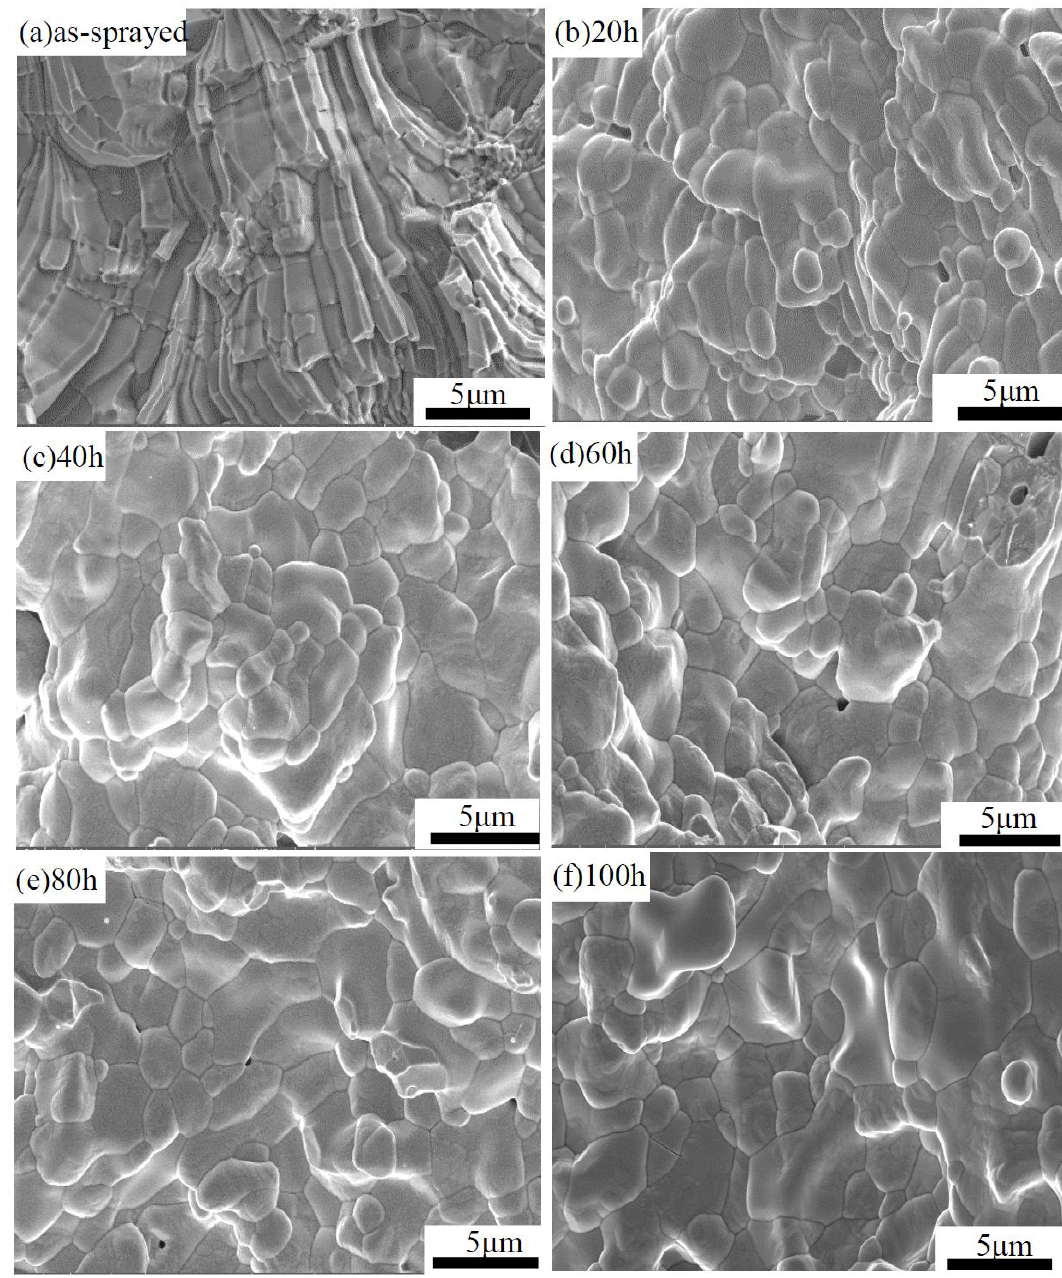
Figure 7. Fracture morphologies of YSZ top coatings before and after thermal aging for different times. ( a ) as-sprayed; ( b ) at 1550 °C for 20 h; ( c ) at 1550 °C for 40 h; ( d ) at 1550 °C for 60 h; ( e ) at 1550 °C for 80 h; ( f ) at 1550 °C for 100 h.